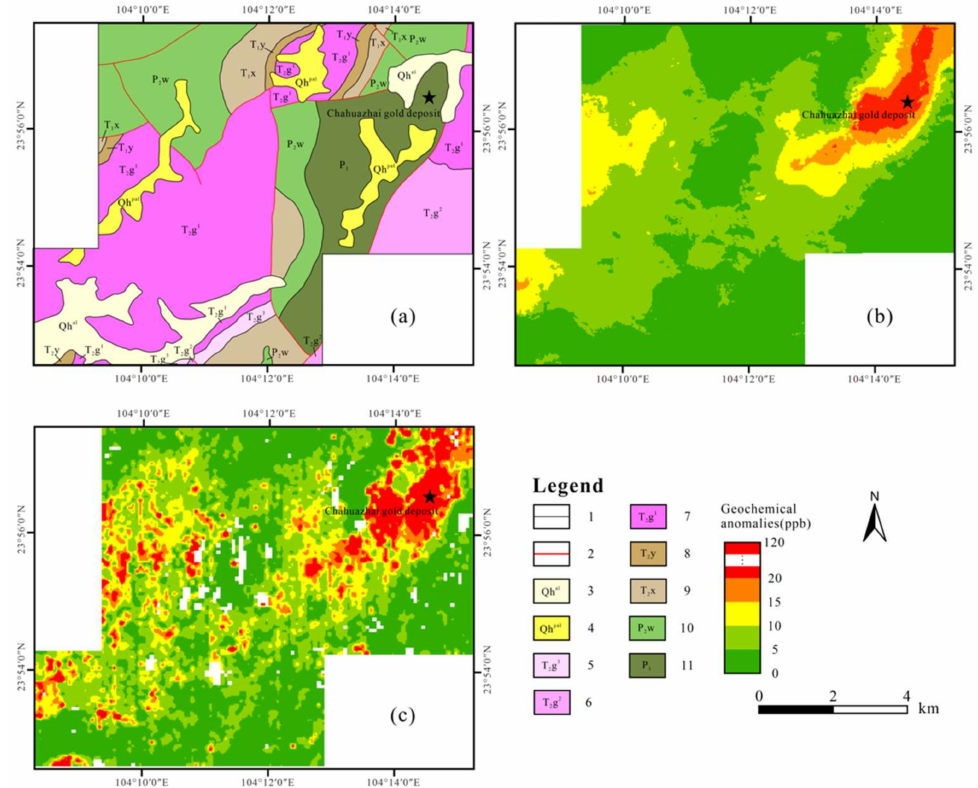
Figure 17. ( a ) Geological background of the study area: 1 . Chahuazhai gold deposit; 2 . Geological boundary; 3 . Fault; 4 . Quaternary Pleistocene alluvium; 5 . Quaternary Pleistocene pulluvial alluvium; 6 . Third member of Gejiu formation of Middle Triassic; 7 . Second member of Gejiu formation of Middle Triassic; 8 . First member of Gejiu formation of Middle Triassic; 9 . Yongningzhen formation of Lower Triassic; 10 . Ximatang formation of Lower Triassic; 11 . Wujiaping formation of Middle Permian; 12 . Lower Permian. ( b ) GWR prediction results. ( c ) Geochemical exploration